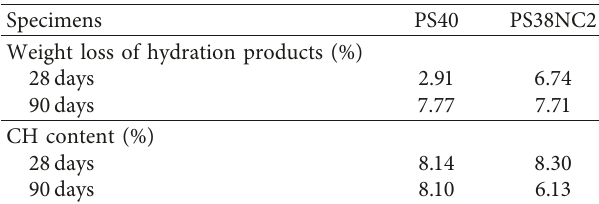
Figure 5: DTG-TG curves of specimens. (a) Hydration for 28days; (b) hydration for 90days. Table 3: Weight loss of hydration products and CH